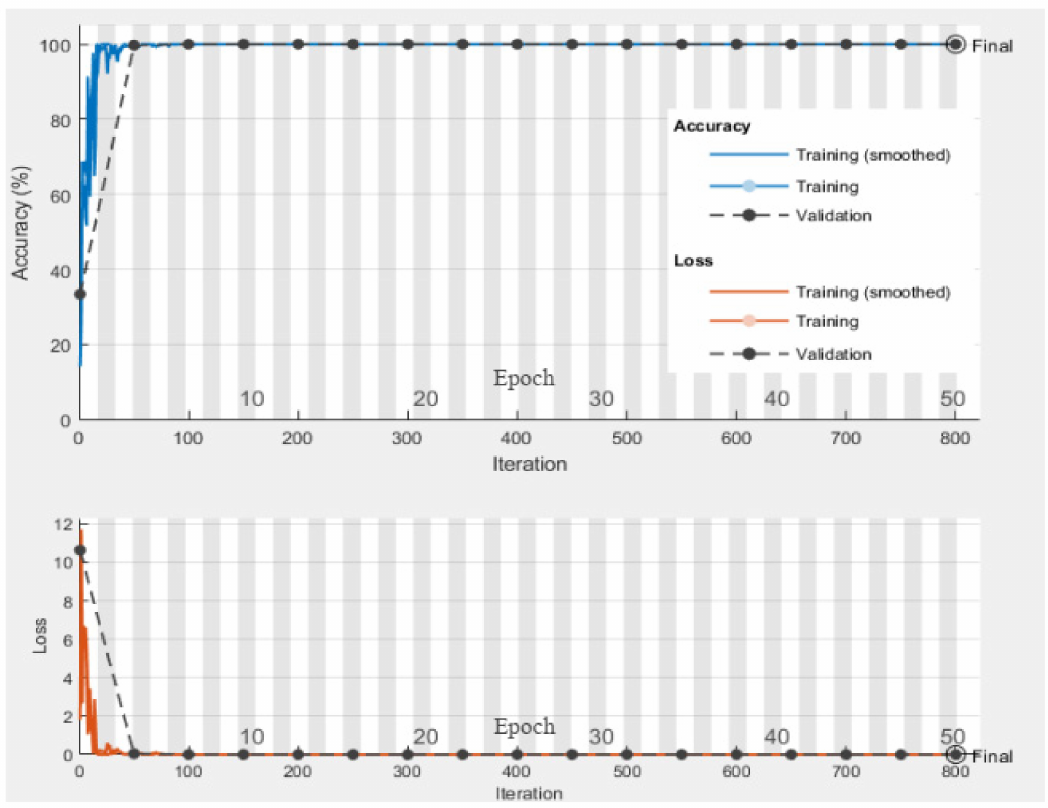
Figure 9 represents the training and validation accuracy and loss curves of the deep